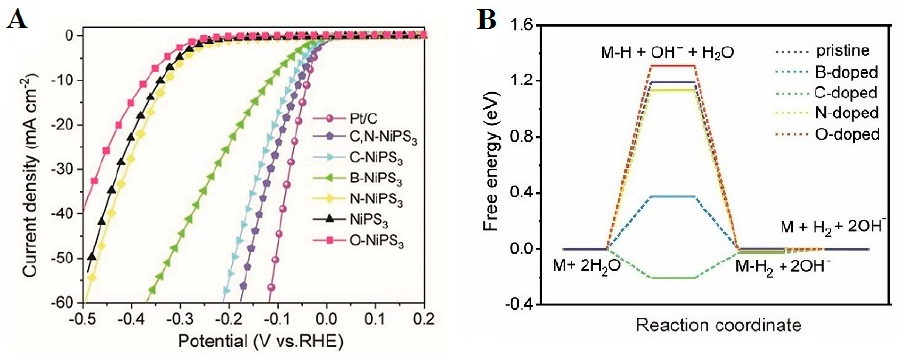
Figure 10. ( A ) Polarization curves of (C, N)-, C-, B-, N-, O-NiPS 3 , pristine NiPS 3 , and Pt / C. ( B ) Calculated free energies of hydrogen adsorption on di ff erent catalysts under steady-state H coverage by the Volmer–Heyrovsky mechanism (reprinted with permission from ref [54]. Copyright © 2020, John Wiley and Sons).